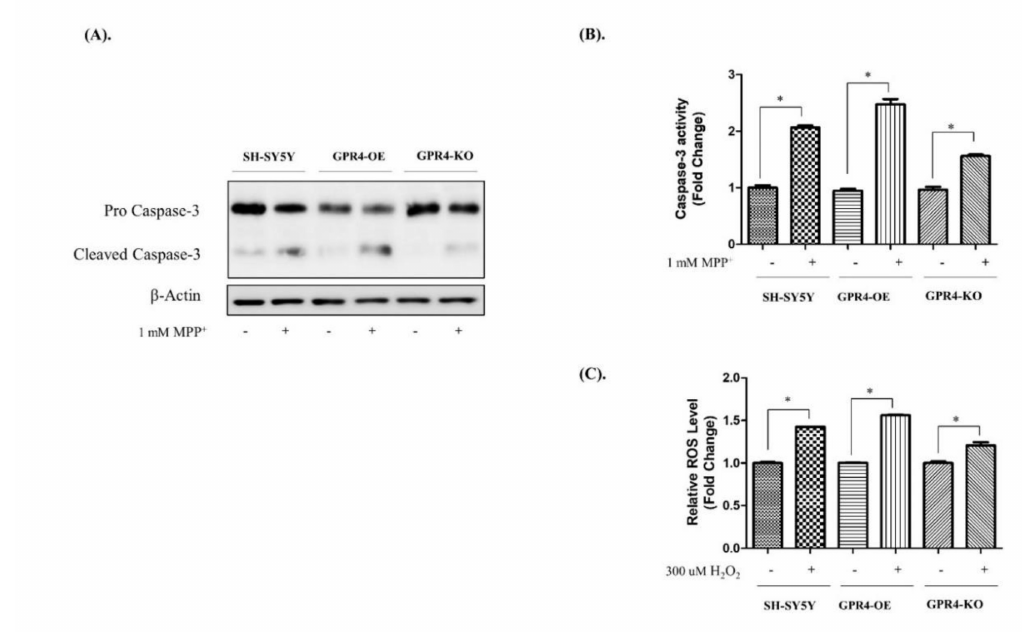
Figure 6. The Caspase-3 activity and intracellular ROS generation in MPP + - and H 2 O 2 -treated SH-SY5Y cells that were stably GPR4-OE or GPR4-KO. 24 h serum-starved SH-SY5Y cells were treated with MPP + (1 mM) for 24 h in serum-free culture media for an immunoblot and a caspase activity assay. SH-SY5Y, GPR4-OE, and GPR4-KO cells were treated with H 2 O 2 (300 µ M) for 1 h in serum-free culture media for a 2 (cid:48) ,7 (cid:48) -dichlorofluorescein diacetate (DCFDA) assay. ( A ) An immunoblot of the pro caspase & cleaved Caspase-3 and β -Actin. ( B ) Caspase-3 activity was measured using a colorimetric assay kit (Sigma, CAS No. CASP-3-C) in MPP + -induced apoptotic cells. ( C ) The relative intracellular ROS level after 1 h of H 2 O 2 (300 µ M) treatment of 24 h serum-starved SH-SY5Y, GPR4-OE, and GPR4-KO cells. β -Actin was utilised as an internal control. Mean ± SEM ( n = 3) was employed to express the data. Tukey’s multiple comparison test was performed using a one-way ANOVA. Each * p < 0.05 refers to the sample concentration compared with the same group of non-treated